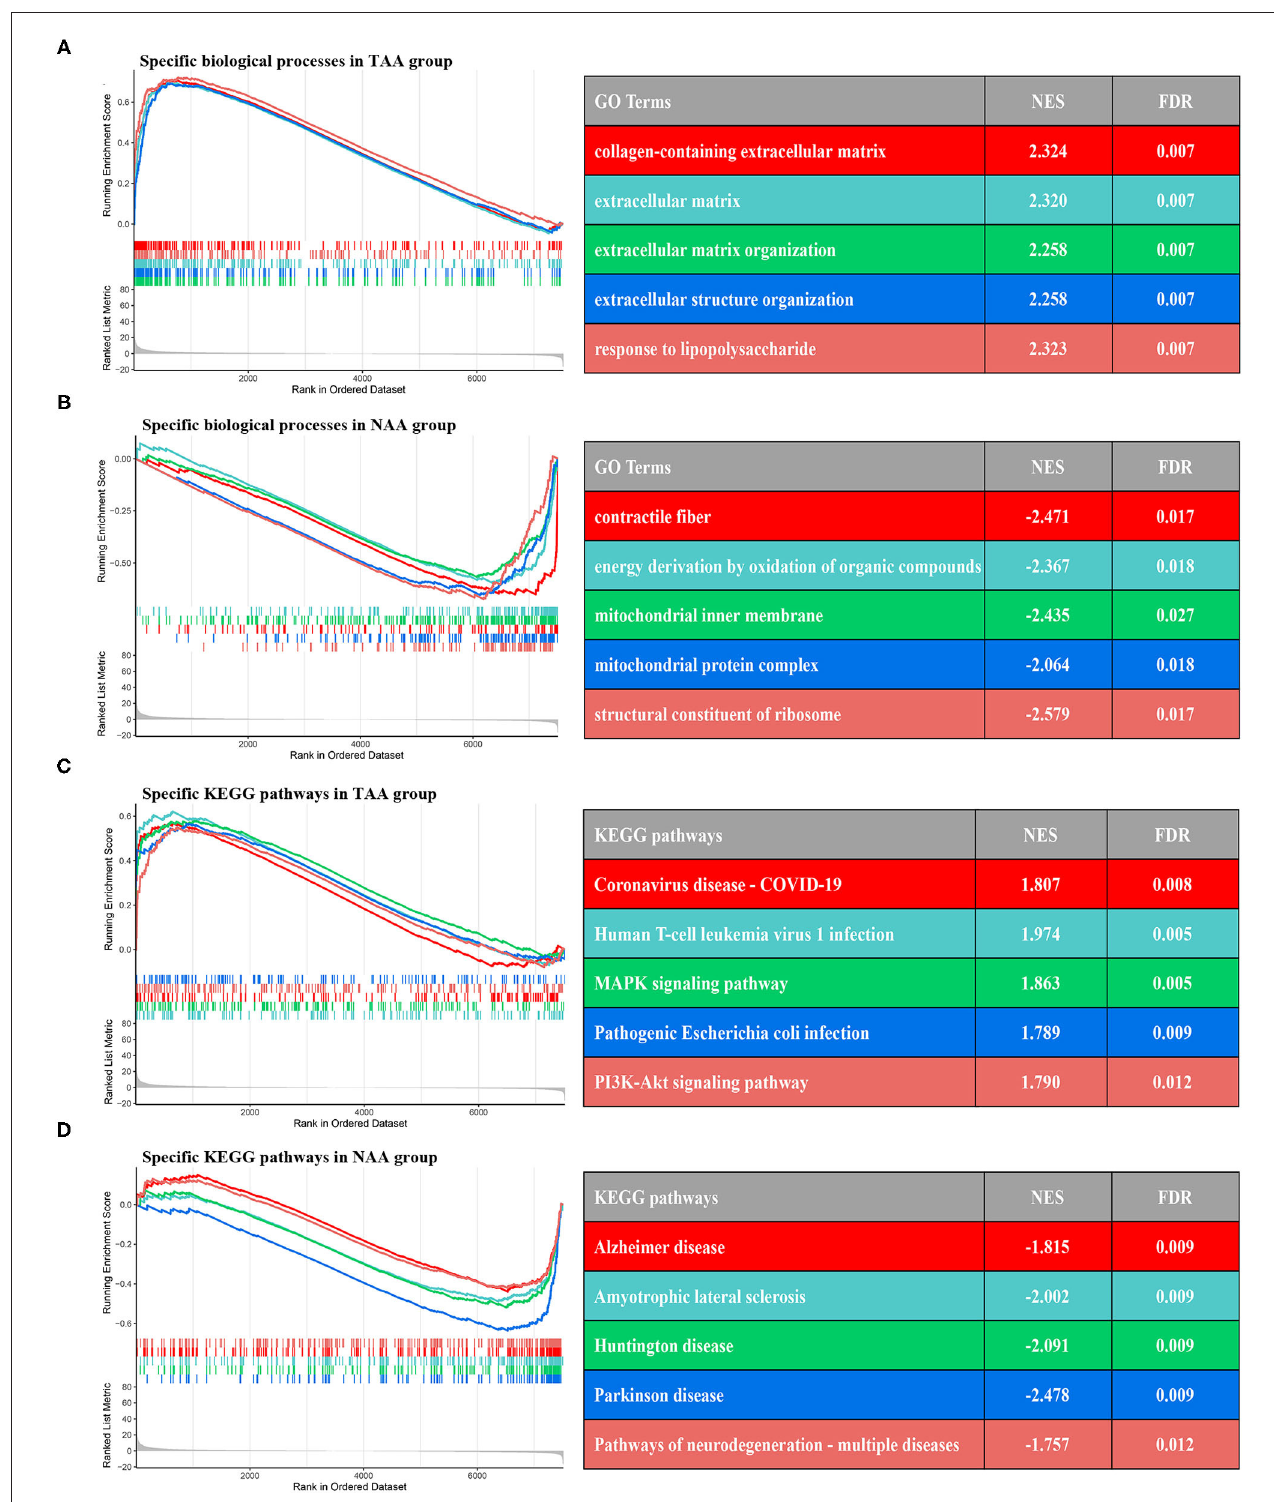
FIGURE 7 | GSEA enrichment analysis between two subtypes. (A,B) The top five GO terms of differential genes in the two groups. (C,D) The top five KEGG pathways of differential genes in the two groups.